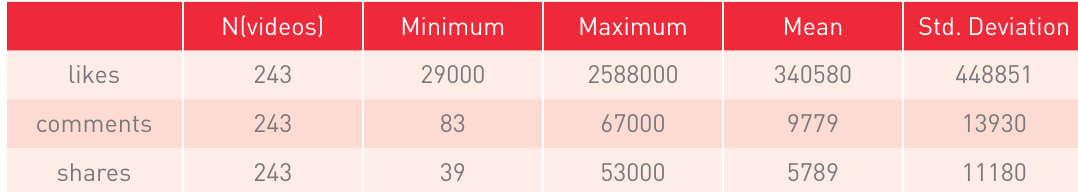
Engagement with the